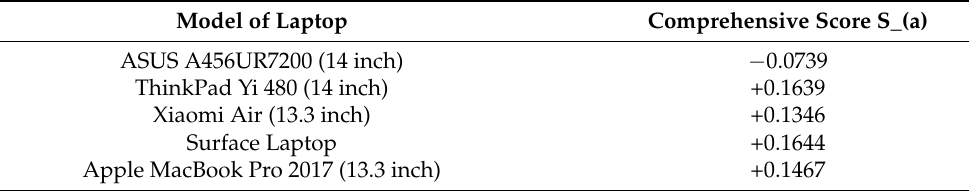
Table 8. Comprehensive score of 5